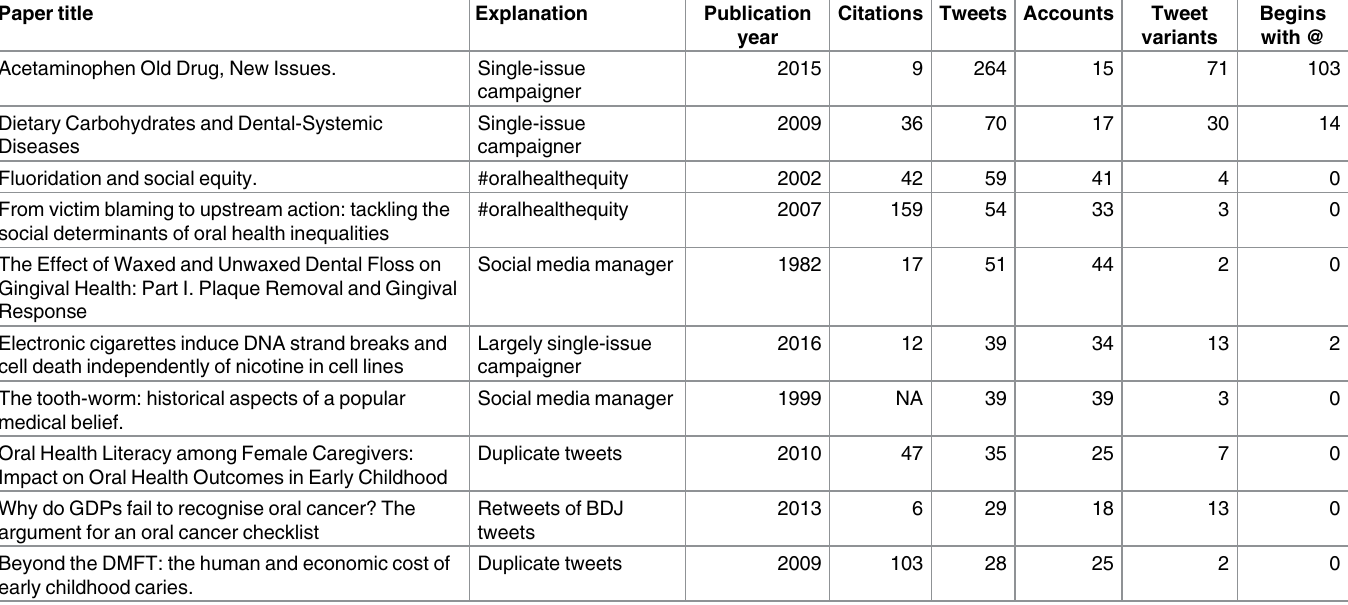
Table 1. Top 10 most tweeted dental